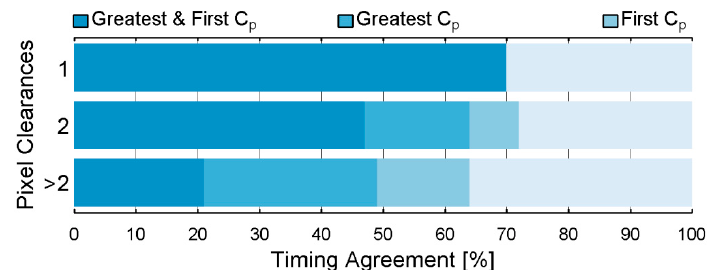
Figure 9. Agreement between clearance timing from the validation sample and the BFAST clearance timing using MODIS Land Surface Water Index (LSWI). Each bar represents a stratum of the validation sample based on the number of clearances that occurred within MODIS pixel samples. Agreement was assessed using two methods: (1) year of the greatest cleared proportion (Greatest C p ); and (2) year of the first forest clearance (First C p ). Often the clearance timing label was both the greatest and first clearance (Greatest and First C p ).